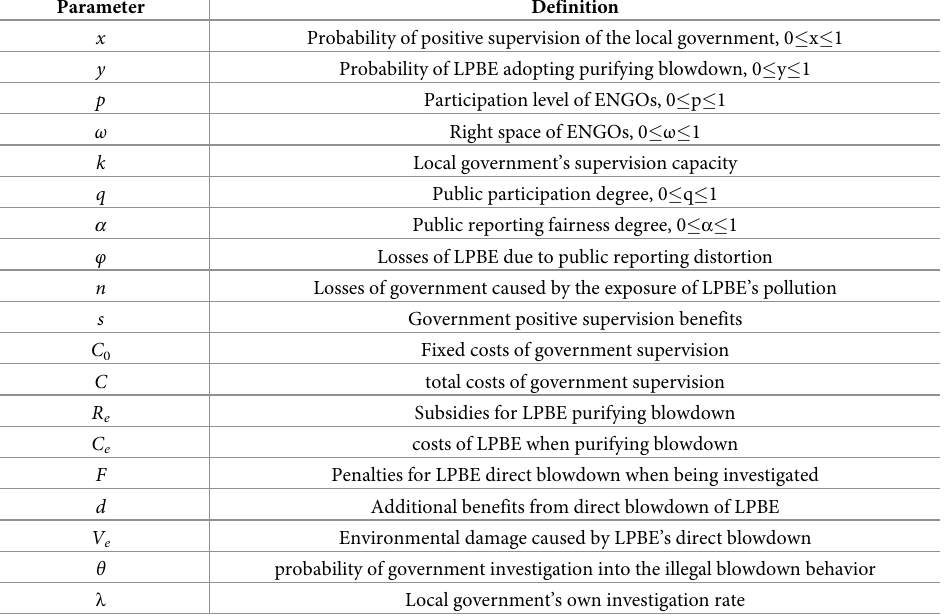
Table 1. Related parameters and definition.